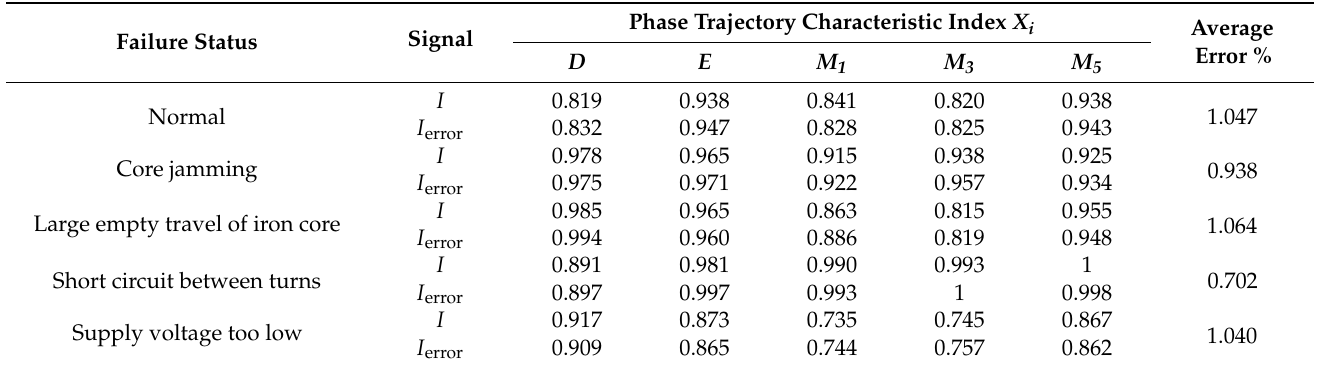
Table 2. Selected results of extracted phase trajectory characteristic indexes.